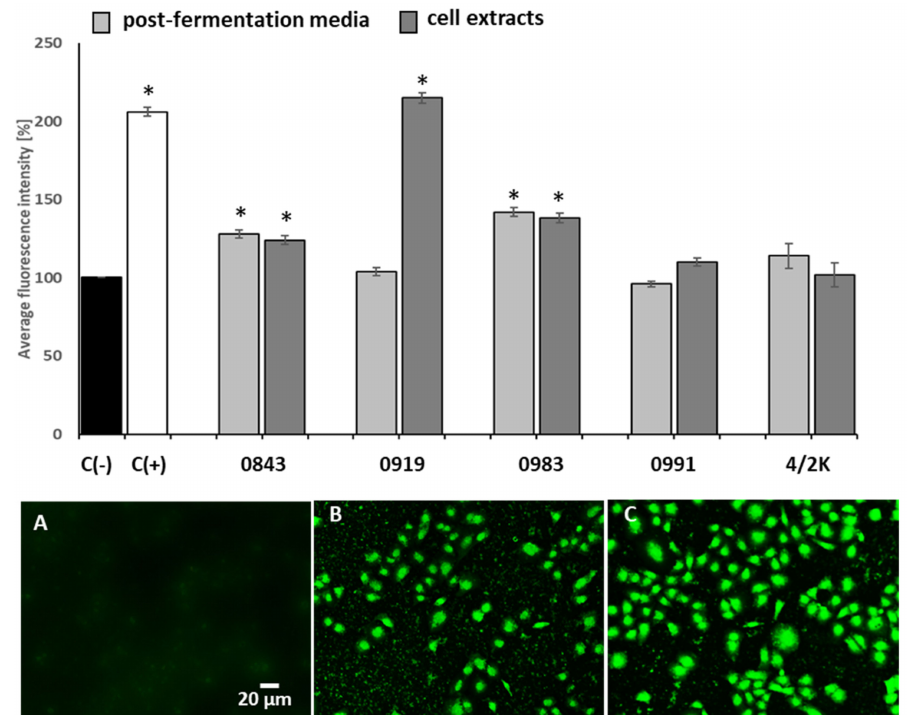
Figure 2. Effect of 5% ( v/v ) post-fermentation media (PFM) and cell extracts (CE) on reactive oxidative species (ROS) generation in Caco-2 cells after 24 h exposure. Each data point represents the mean ± SD, n ≥ 4. * Results significantly different from unexposed control cells, C( − ), p ≤ 0.05: ( A – C ) representative microphotographs of 2 (cid:48) ,7 (cid:48) -dichlorofluorescin diacetate (DCFH–DA)-stained Caco-2 cells: C( − , untreated Caco-2 cells ( A ); Caco-2 cells exposed to 10% PFM of L. brevis 0983 ( B ); C(+), positive control (200 mM H 2 O 2 ) ( C ) observed under a fluorescent microscope (Nikon Eclipse Ci H600L, Japan) with 20 × objective.